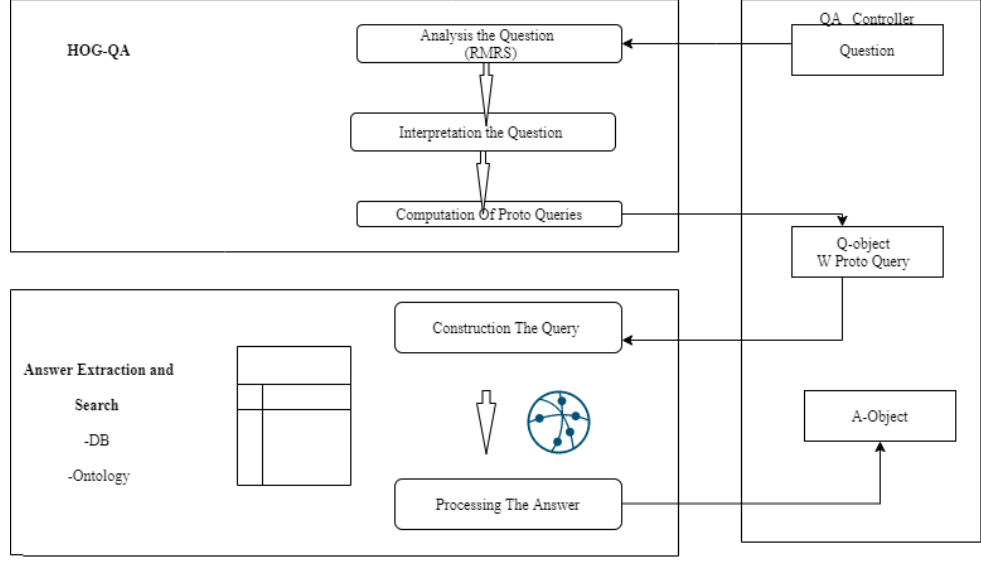
Figure 7. Design of domain-restricted